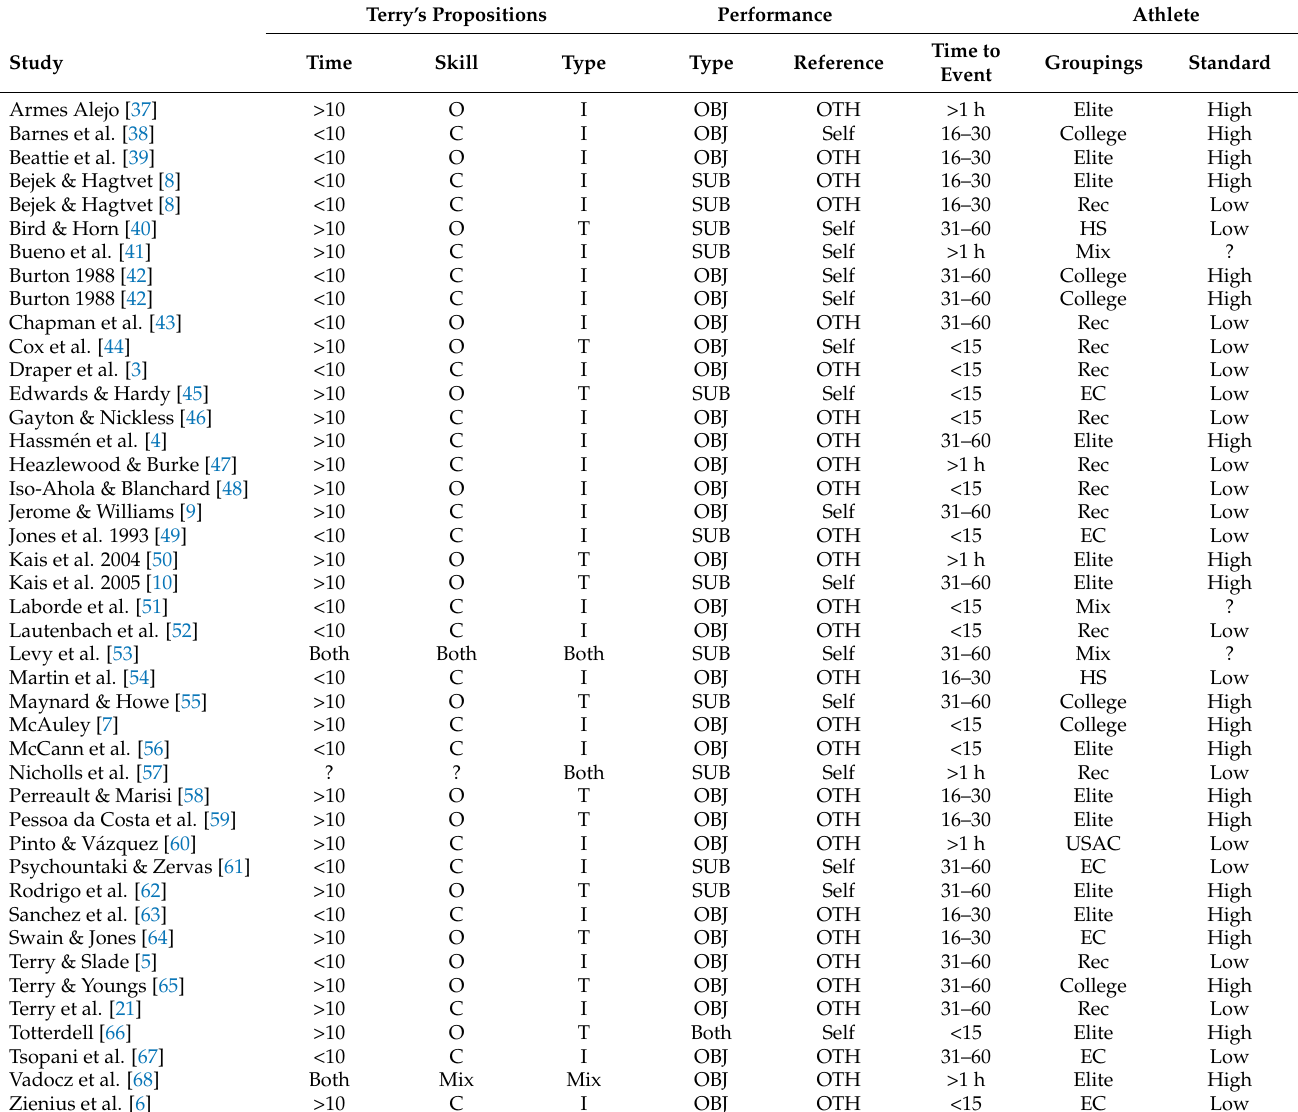
Table 3. Moderator Coding for Terry’s Proposition, Performance Characteristics, and Confidence Time to Event